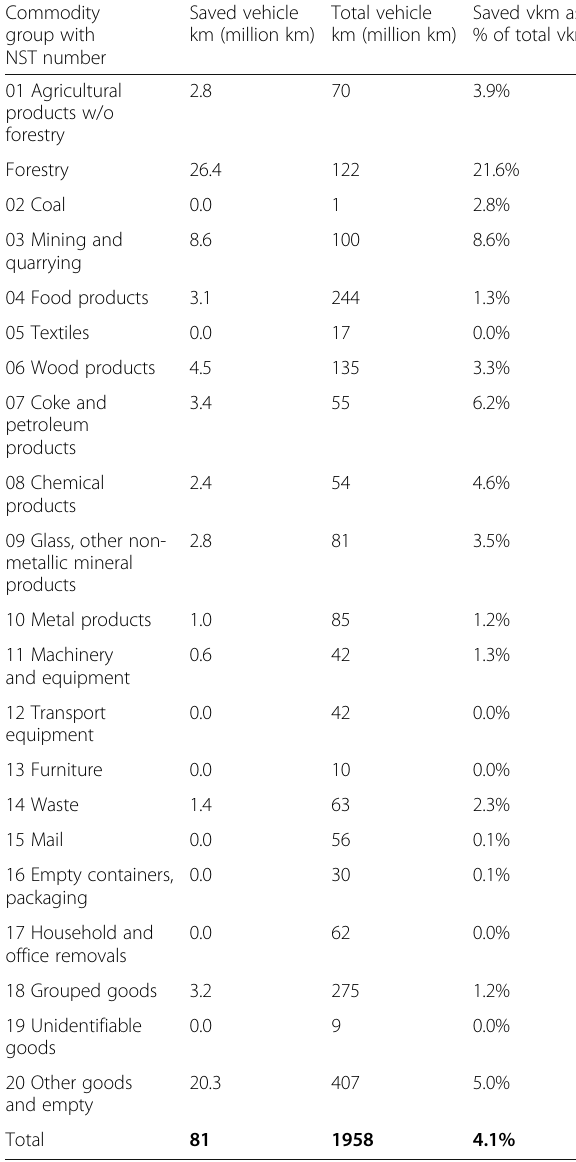
Table 4 Vehicle kilometres saved by using HCVs in 2017 by